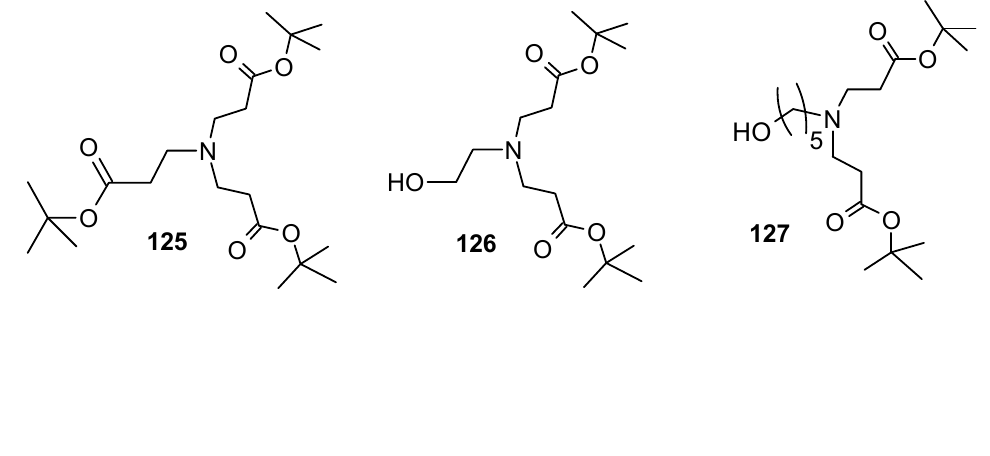
Figure 9. Starting materials for amine-containing polyester dendrimers